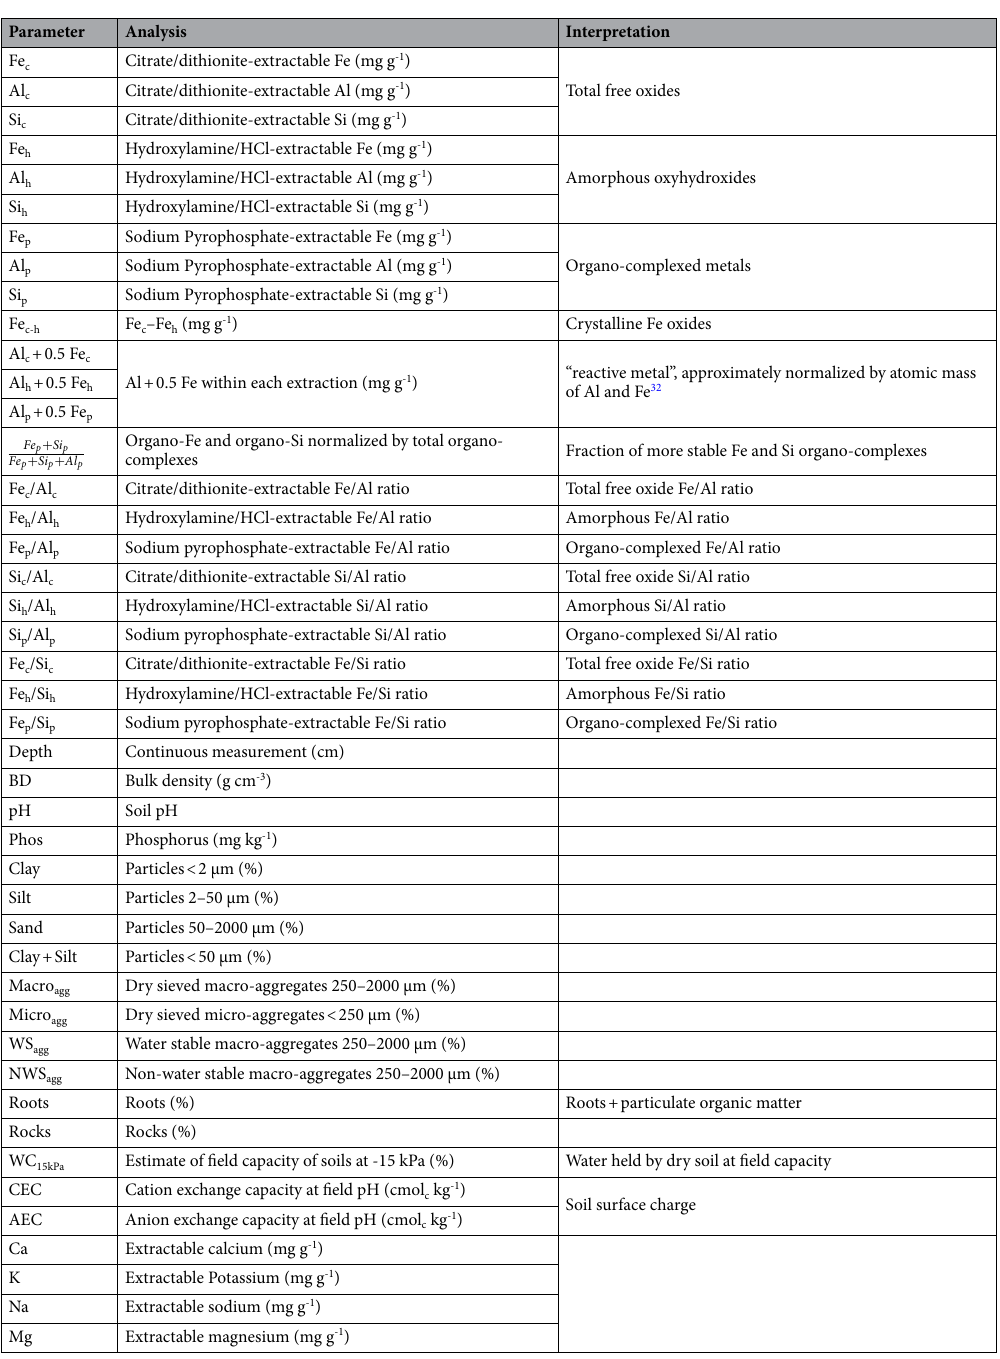
Table 2. Potential physicochemical soil predictors of SOC content, k 2 , k 1 in linear mixed